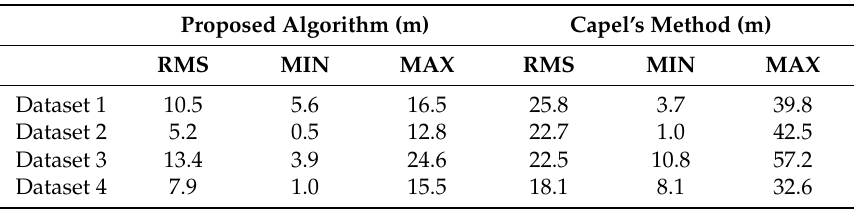
Table 1. Mosaicking error for proposed algorithm and Capel’s approach.